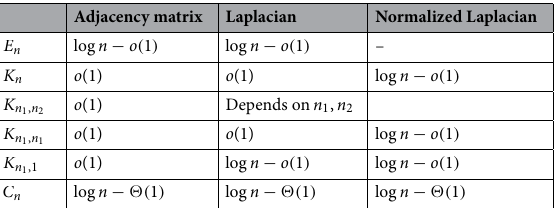
Table 1. Asymptotic behavior of the entropy calculated for various graph classes described in “Entropy of specific graph classes”